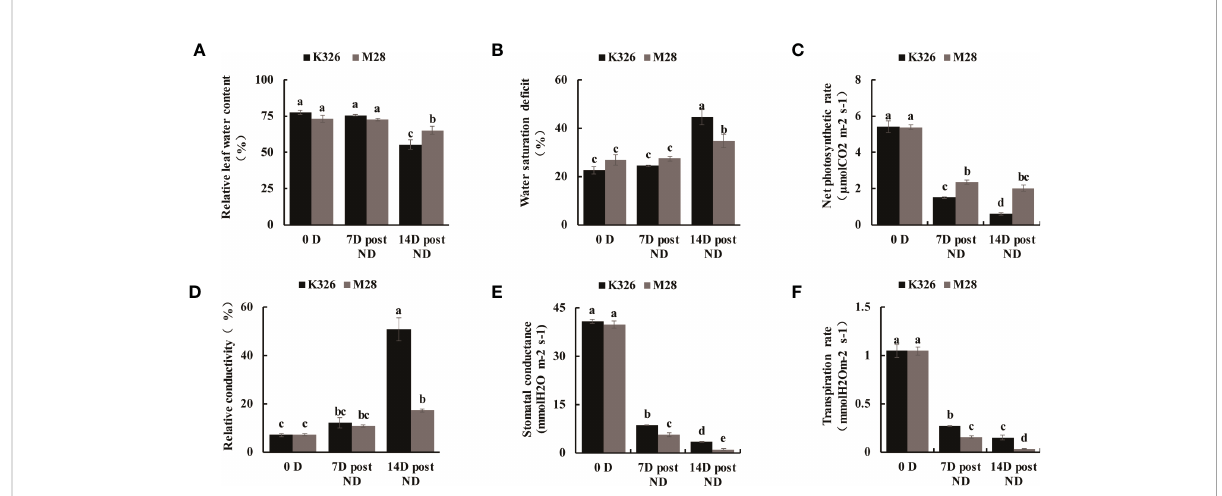
FIGURE 2 Physiological comparisons between tobacco K326 and M28 at different time points after exposing to ND. (A, B) Relative leaf water content at 0 D,7 D,14 D post ND, and 0h,4h,24h between tobacco K326 and M28. (C) Net photosynthetic rate at 0 D,7 D,14 D post ND between tobacco K326 and M28. (D) Relative conductivity at 0 D,7 D,14 D post ND between tobacco K326 and M28. (E) Stomatal conductance at 0 D,7 D,14 D post ND between tobacco K326 and M28. (F) Transpiration rate at 0 D,7 D,14 D post ND between tobacco K326 and M28.Different letters represent signi fi cant differences (P< 0.05, one-way ANOVA).The difference is not signi fi cant if there is a letter with the same marker, and signi fi cant if there is a letter with a different marker.